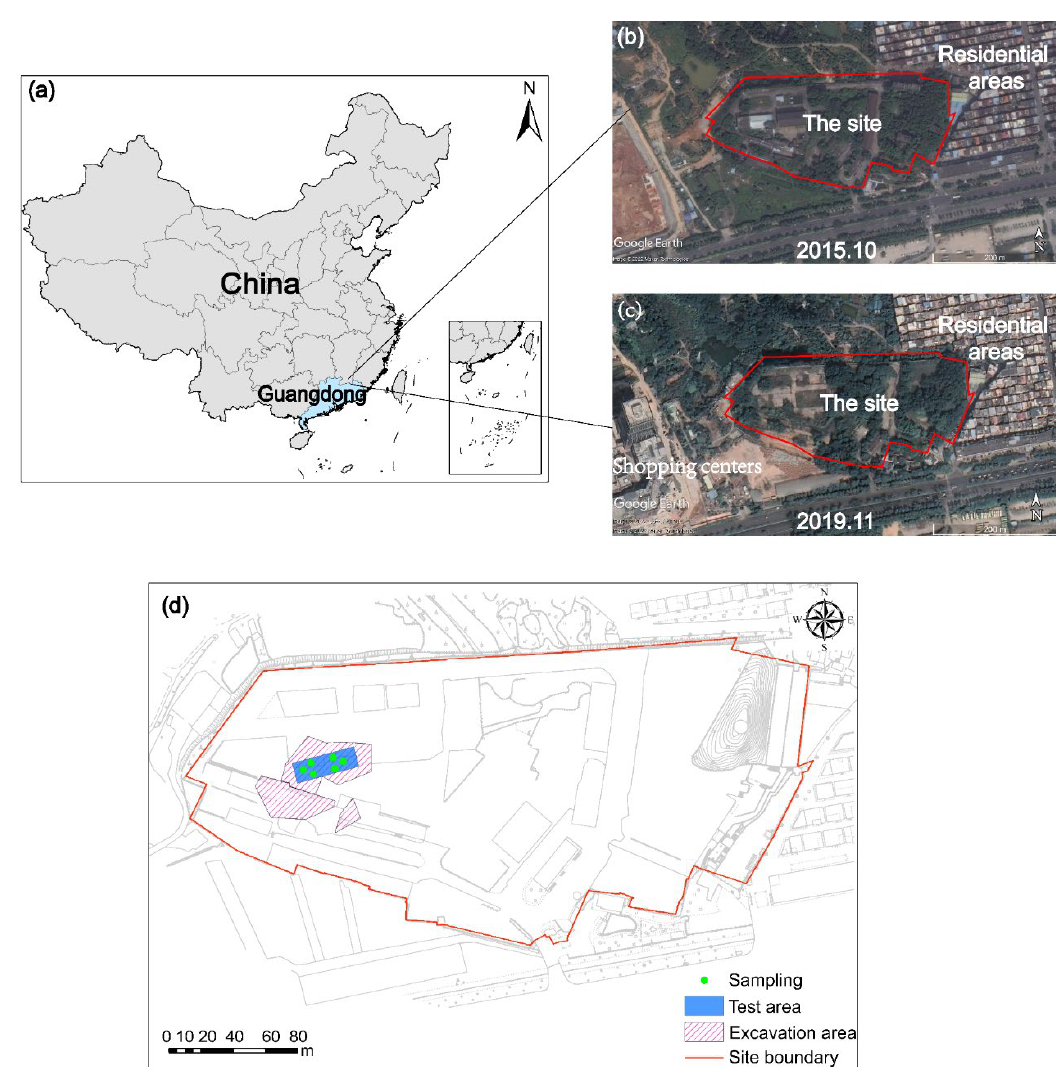
Figure 1. ( a ) Geographical location of the research site; ( b ) satellite aerial photos before site closure and relocation (October 2015); ( c ) satellite aerial photos after site closure and relocation (November 2019); ( d ) excavation area, test area, and sampling points.